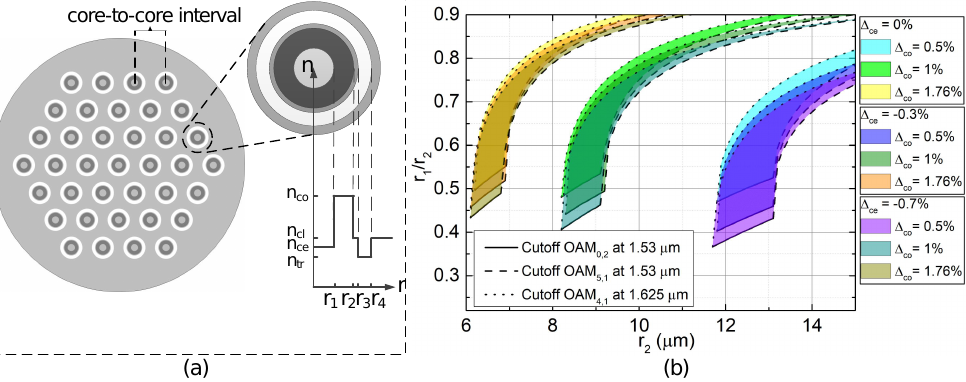
Figure 13. ( a ) The schematic refractive index profile of a trench-assisted MRCF. ( b ) The design regions for supporting 5 OAM mode groups in C+L